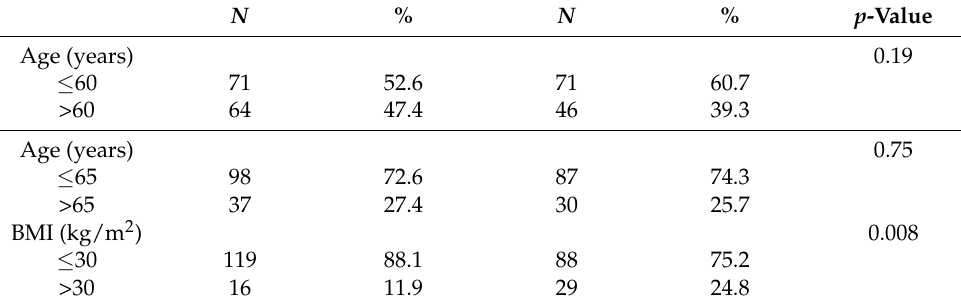
Table 2. Subgroup analysis by different age and BMI